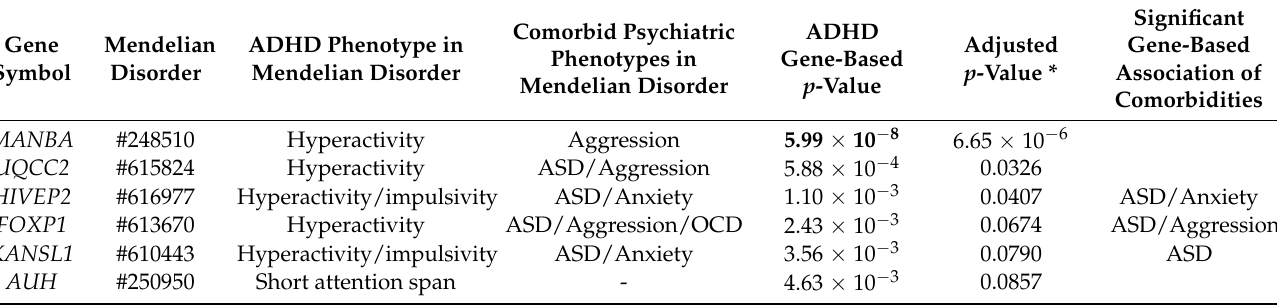
Table 2. Significant results from the GWAS gene-based association studies on the OMIM gene list